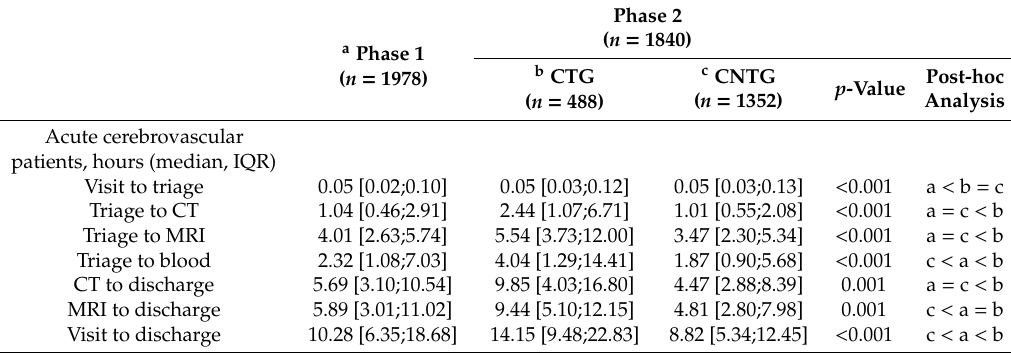
Table 3. Number of activities and duration of each process in patients with presumed acute cerebrovascular